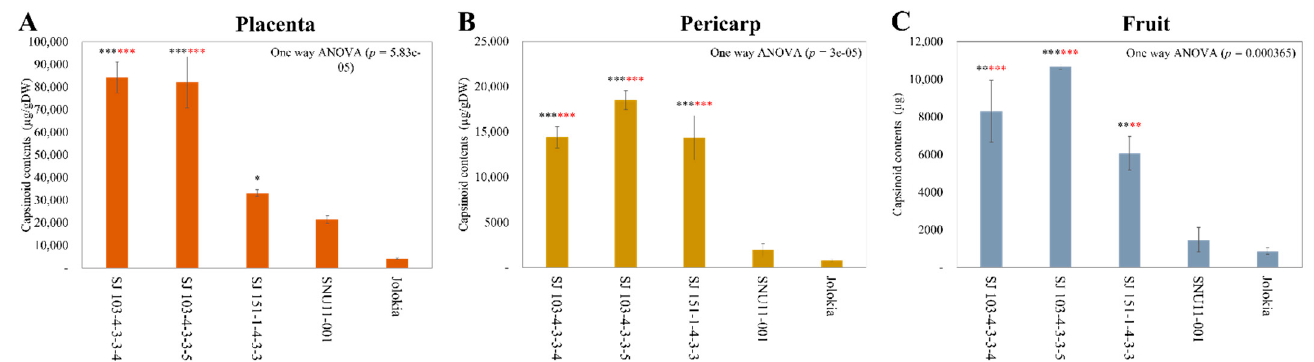
Figure 5. Capsinoid contents of the placenta ( A ), pericarp ( B ), and fruit ( C ) in the ‘SJ’ F7 lines. Bars represent standard error ( n = 3). Black and red asterisks indicate a statistical difference from ‘BJ’ and ‘SNU11–001’ respectively, as revealed using a one–way ANOVA and Fisher LSD, with p –values between 0 and 0.001 shown with ‘***’, lower than 0.01, ‘**’ and lower than 0.05, ‘*’.